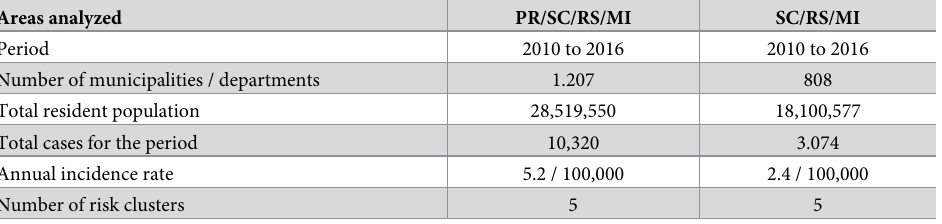
Table 2. General description of the relative risk analyses for new cases of leprosy in the southern region of Brazil and in the province of Misiones, Argentina, 2010 to